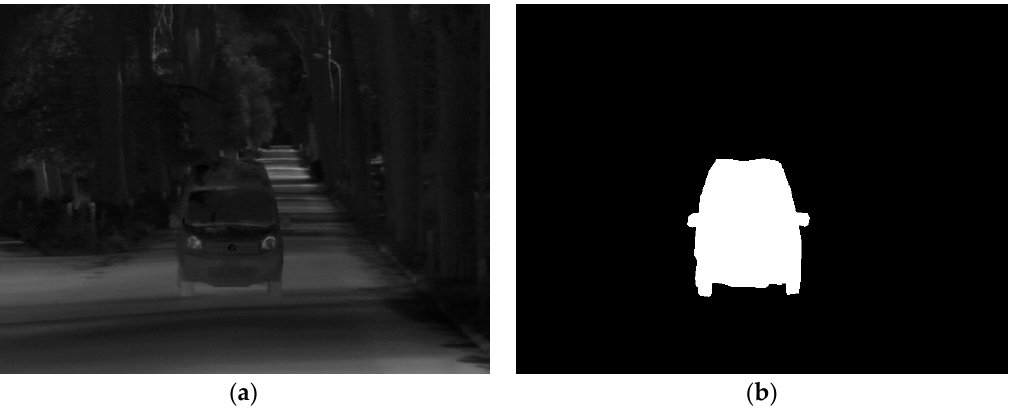
Figure 4. Example frame of a video sequence containing a large moving object ( a ); and corresponding detection map output by the proposed algorithm ( b ).